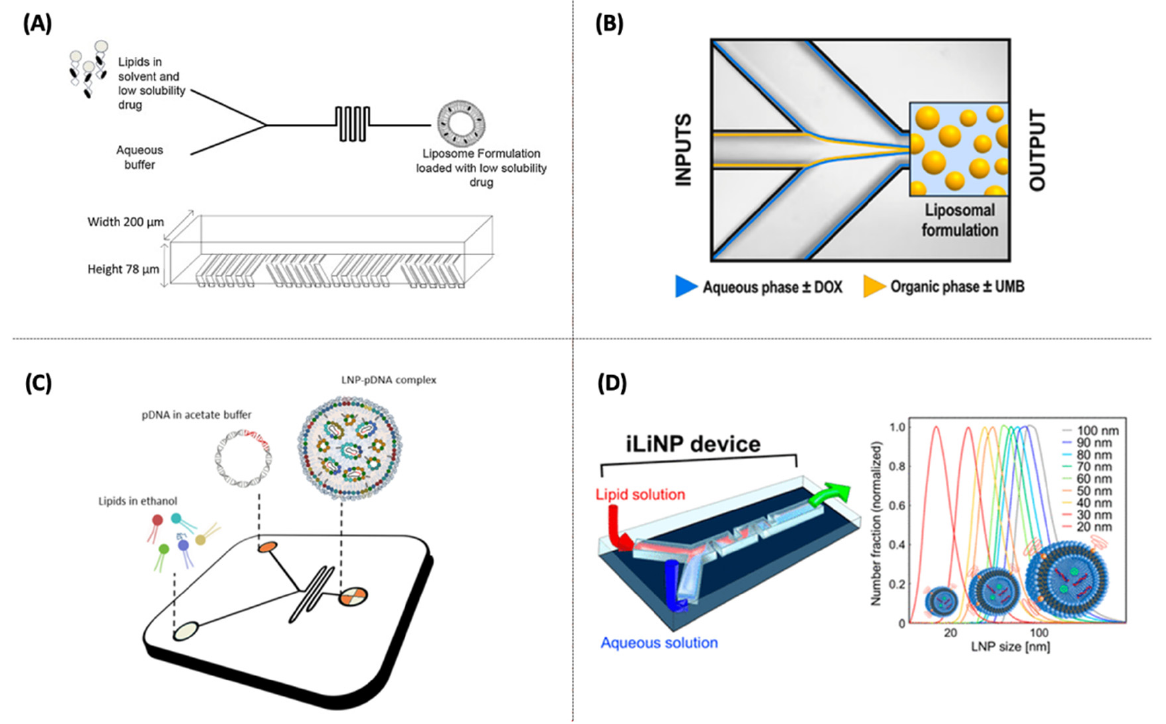
Figure 4. ( A ) Schematic depiction of the liposome formation process based on the SHM design, a chaotic advection micromixer for drug-loaded liposomes, and the chamber layout [68]. ( B ) Microfluidic system schematic (5-input chip mixing junction, Dolomite, Royston, UK), highlighting the mixing junction [85]. ( C ) Schematic of the lipid nanoparticle-plasmid DNA (LNP-pDNA) complex formu- lation strategy employing the Y-shape staggered herringbone micromixer (SHM) (NanoAssemblr Benchtop™, Vancouver, BC, CA) [89]. ( D ) Three-dimensional view of the invasive lipid nanoparticle (iLiNP) device and the size range of LNPs synthesized